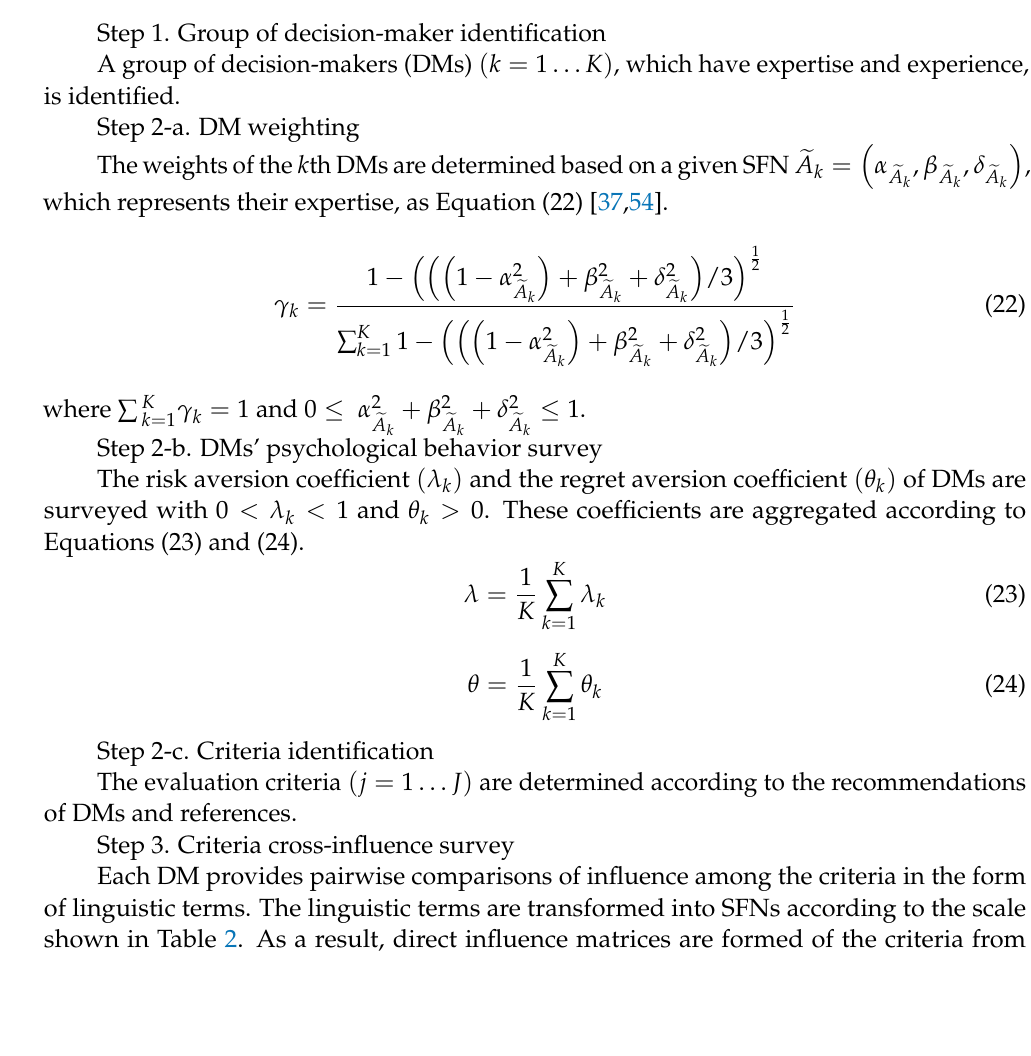
Figure 1. The proposed spherical fuzzy bounded rationality decision-making approach.